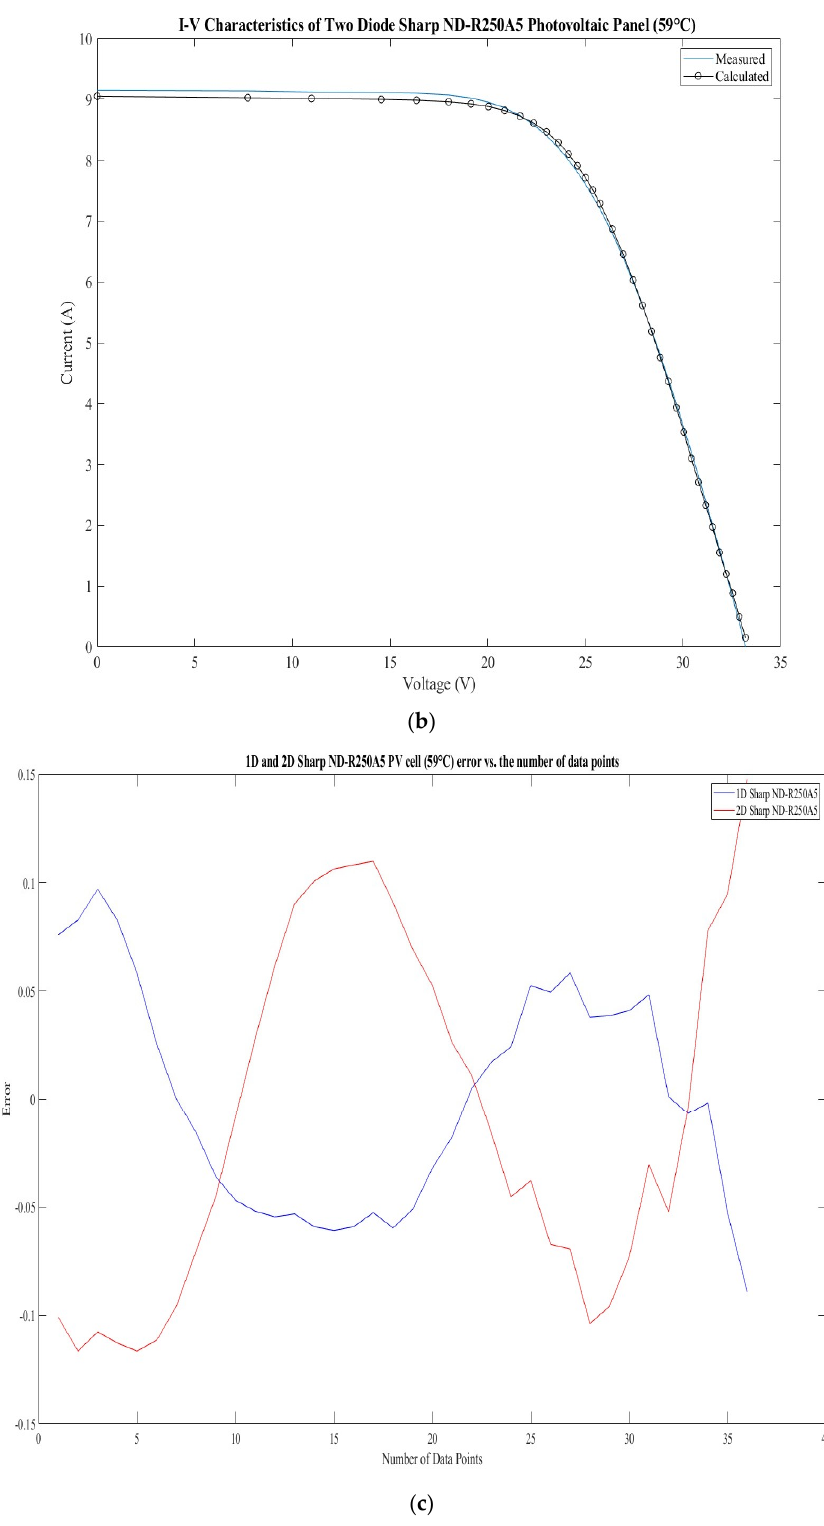
Figure 6 . Sharp ND-R250A5 photovoltaic panel: ( a ) measured and calculated I-V characteristic for SDM; ( b ) measured and calculated I-V characteristic for DDM; ( c ) SDM and DDM errors comparison .